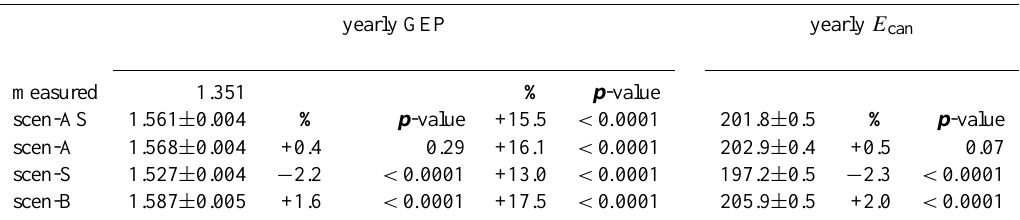
Table 5. Measured and simulated yearly gross ecosystem productivity (GEP; kgCm − 2 y − 1 ) and simulated canopy transpiration ( E can ; kgH 2 Om − 2 y − 1 ) under the four scenarios (mean ± SE), with the percentagewise difference and p -values of t -test comparison with scen-AS results. Also given are the percentagewise difference and the p -values of One Sample t -test comparison of simulated GEP with measured GEP. n =